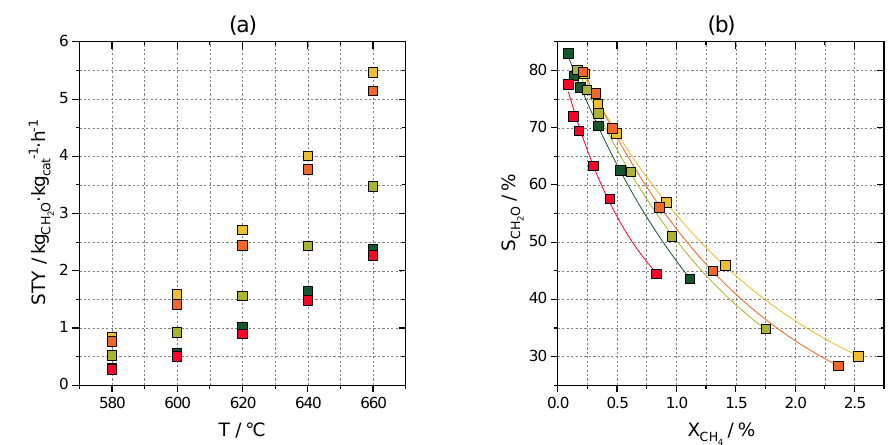
Figure 2. Catalytic performance of V-SBA-15 materials in the selective oxidation of methane between 580 and 660 ◦ C (25 mg catalyst, gas hourly space velocity (GHSV) = 720,000 L · kg − 1 · h − 1 , CH 4 :O 2 9:1): ( a ) methane conversion X CH , ( b ) formaldehyde selectivity S CH . 4 2 O